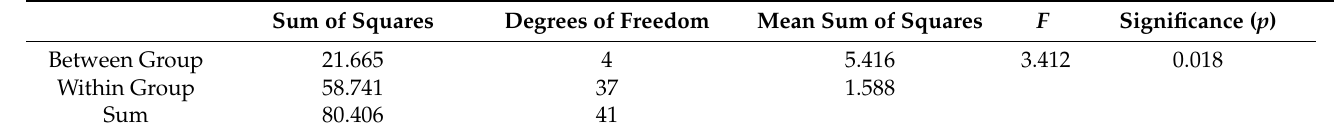
Table 3. One-way ANOVA of log LOS for different anti-drug MDROs.